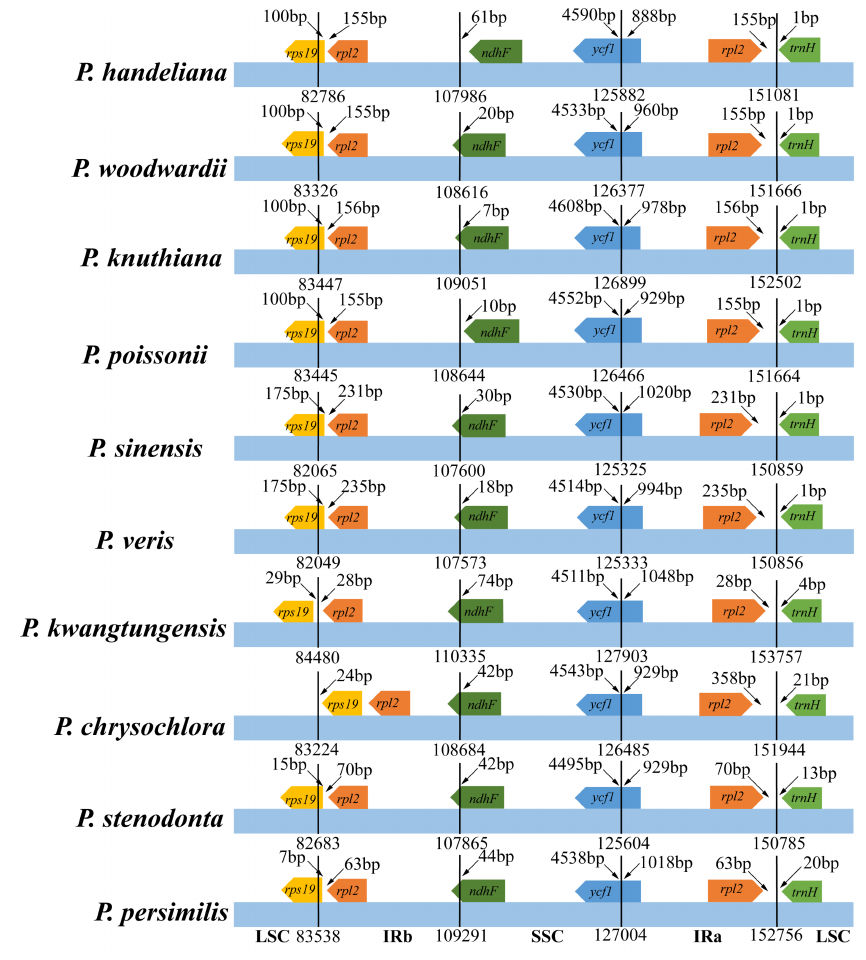
Figure 3. Comparison of the LSC, IR, and SSC border regions among the 10 Primula plastid genomes. Number above the gene features means the distance between the ends of genes and the borders sites. These features are not to